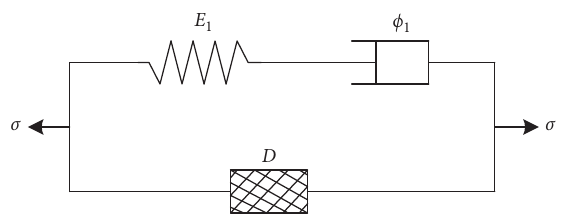
Figure 16: Improved damaged ZWT model.